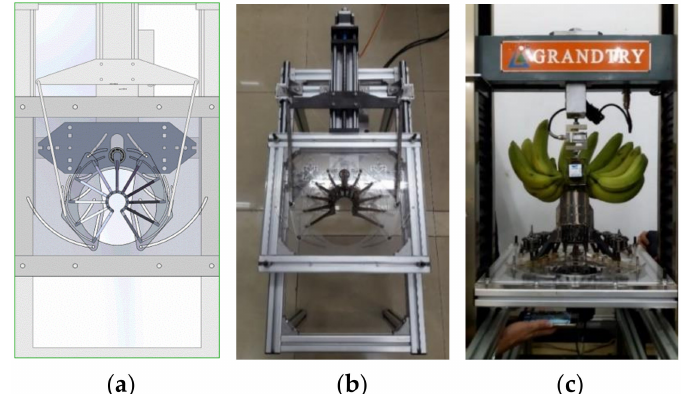
Figure 8. Vibrated de-handing device based on deployable mechanism: ( a ) 3D model of the deployable mechanism; ( b ) prototype of the vibrated de-handing device; and ( c ) experiment of banana de-handing based on the vibrated cutting-type